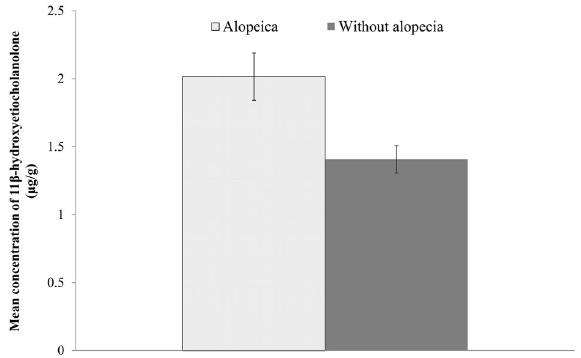
Figure 7. Mean concentration and standard error of 11β-hydroxyetiocholanolone of fecal samples collected from Formosan macaques with and without alopecia in Mt.